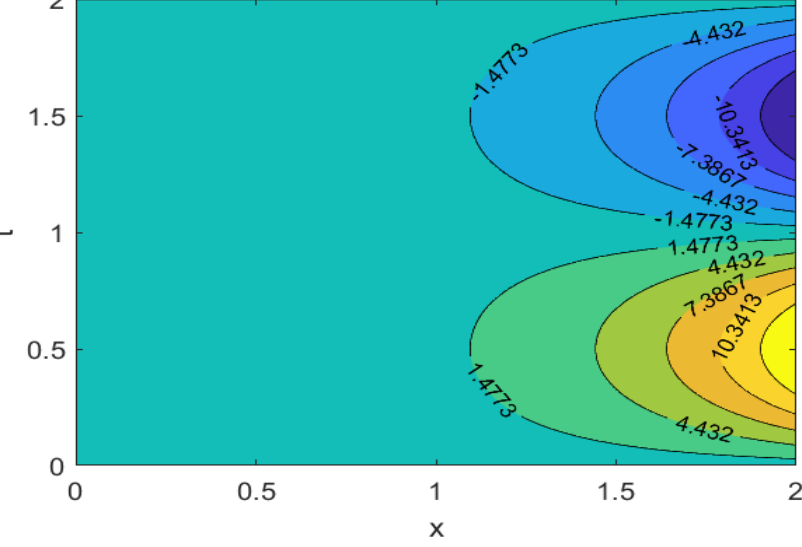
Figure 3. Contour plot of u h ( x , t ) when α = 1.3, T = 2, L = 2, M = N =